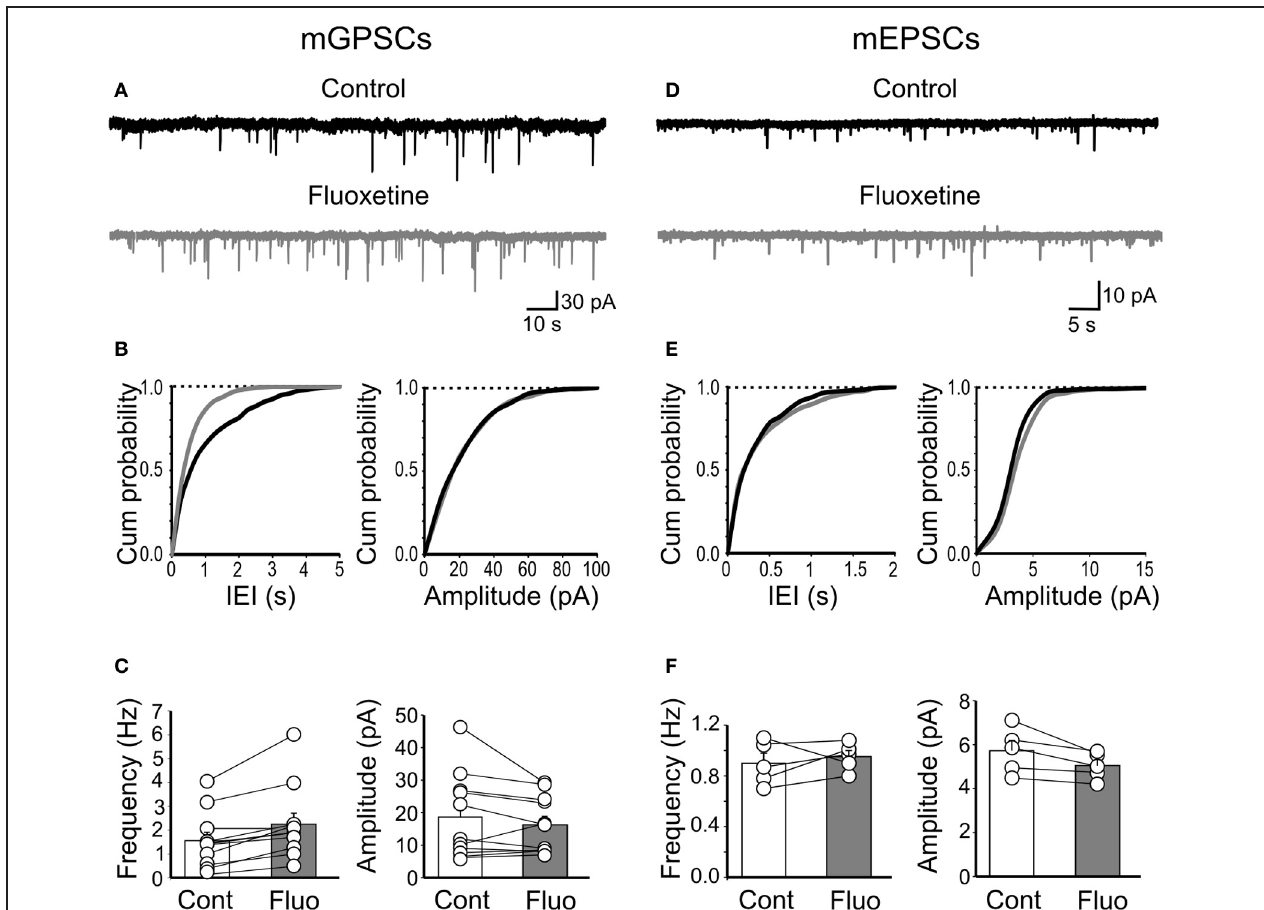
(black) and during (grey) application of fluoxetine. (C) Summary plots of the mean frequency ( n = 11; p = 0 . 002) and amplitude ( n = 11; p = 0 . 17) of all cells tested ( ± SEM). (D–F) as in (A–C) but for mEPSCs (recorded in the presence of bicuculline, 10 μ M, TTX, 1 μ M). No significant differences in frequency ( n = 5; p = 0 . 5) or amplitude ( n = 5; p > 0 . 05) of mEPSCs were